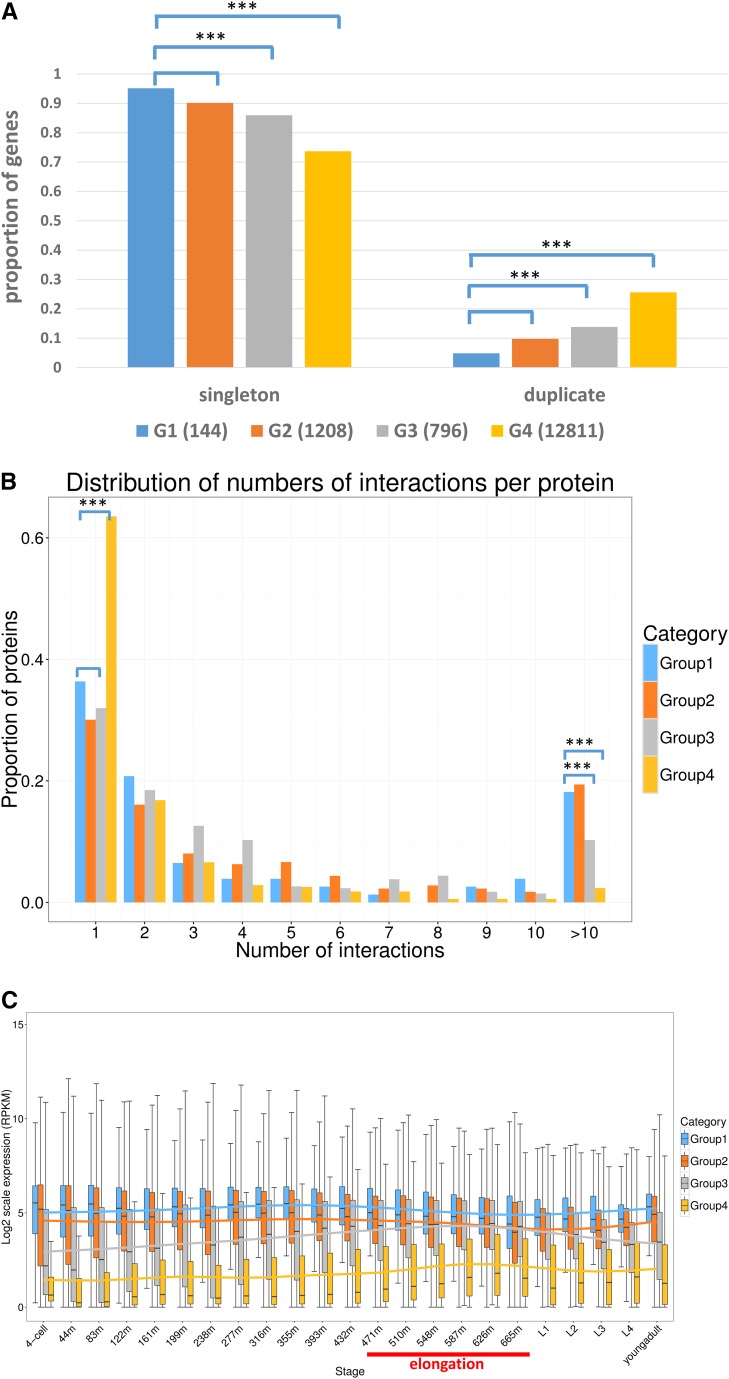
Gene essentiality analysis. Group one (G1): essential genes that were isolated through genetic screens in the Baillie laboratory or collaborations and are fully sequenced or rescued by fosmids (Maciejowski et al. 2005; Jones et al. 2007; Chu et al. 2014; S. Ono, personal communication) (143 in total, including 60 genes from the current study). Group two (G2): essential genes that have published alleles supporting lethal phenotypes (1208 in total). Group three (G3): nonessential genes that have known alleles supporting nonlethal phenotypes (796 in total). Group four (G4): no-phenotype supporting genes that have no observable phenotypes caused by either RNAi or known alleles (12,811 in total). Given that this group contains the majority of protein-coding genes in C. elegans, most genes in this group are expected to be nonessential. The four groups are labeled in blue, orange, gray, and gold, respectively. (A) The proportion of singletons and duplicates in the four groups. The x-axis shows singletons and duplicates from the groups. Significant differences (*** P-value < 0.001) were observed between G1 and G3, and between G1 and G4. (B) The distribution of number of interactions per protein (Stark et al. 2006). The x-axis shows the number of interactions per protein and the y-axis is the proportion of proteins. (C) The developmental stage-specific expression pattern and expression level of genes in four groups. The x-axis shows 23 developmental stages, embryos to young adults, from four cells. m in the x-axis is short for minutes of embryonic development. Each bar represents the distribution of the normalized expression level (RPKM in log2 scale) of each gene in each of four groups for each developmental stage. The linear regression trend line is drawn for each group in their respective color. The stages of embryonic elongation are underlined in red. The boxplot was computed using R and the function ggplot2, which uses a 95% C.I.